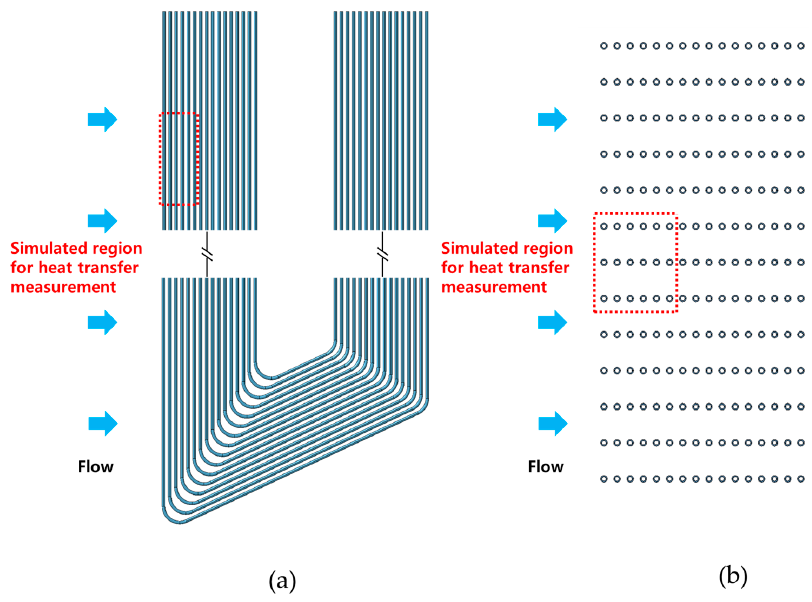
Figure 2. ( a ) Side view of final super heater; ( b ) Top view of final super